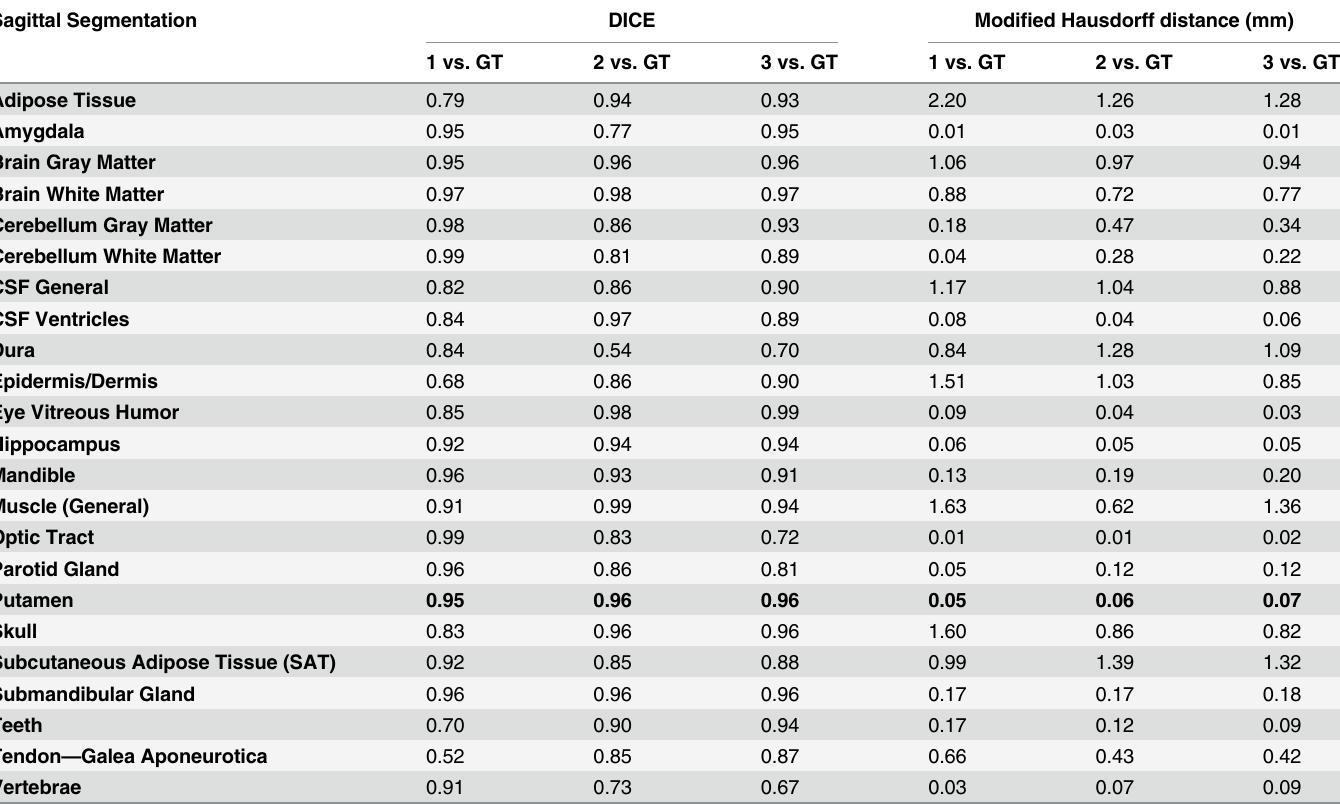
Table 5. Inter-operator variability across structures assessed on the sagittal